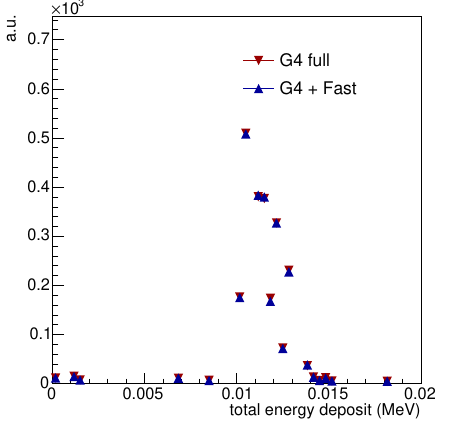
Figure 4. Total energy distribution obtained from a GEANT4 full simulation and a fast-simulation-like VMC implementation drawing from the full simu- lation